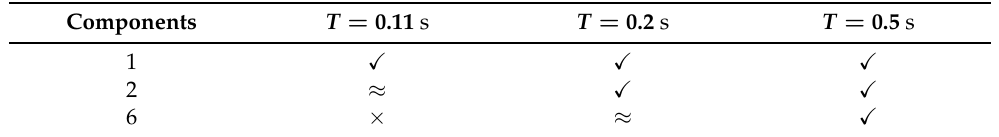
Figure 12. Example of interaction with multiple components. ( a ) the two components are perfectly aligned on the blade before the free fall; ( b ) one component is falling on the other which is starting the free falling motion. The four-bar linkage system is highlighted in red, while the blades are highlighted in green. Table 5. Experimental results of multiple rotations with different T and a different number of components. The blades are proven to be very effective by design with few components, but for small T and a high number of components some problems may